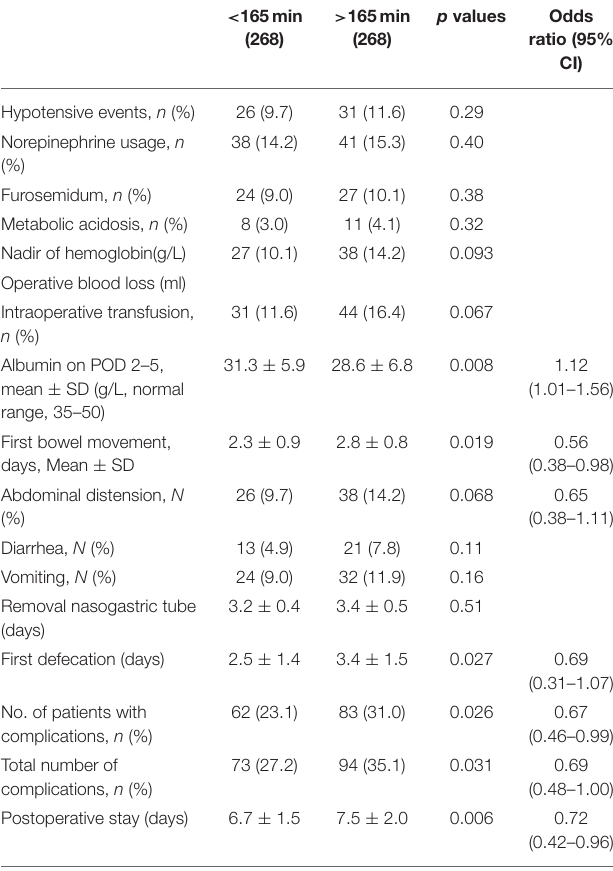
TABLE 4 | Outcome characteristics in the matched population with operative times above and below